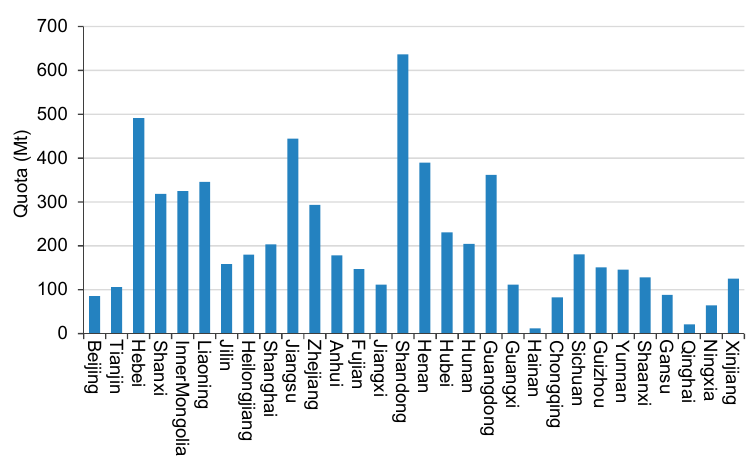
Figure 4. Quota allocation across regions.